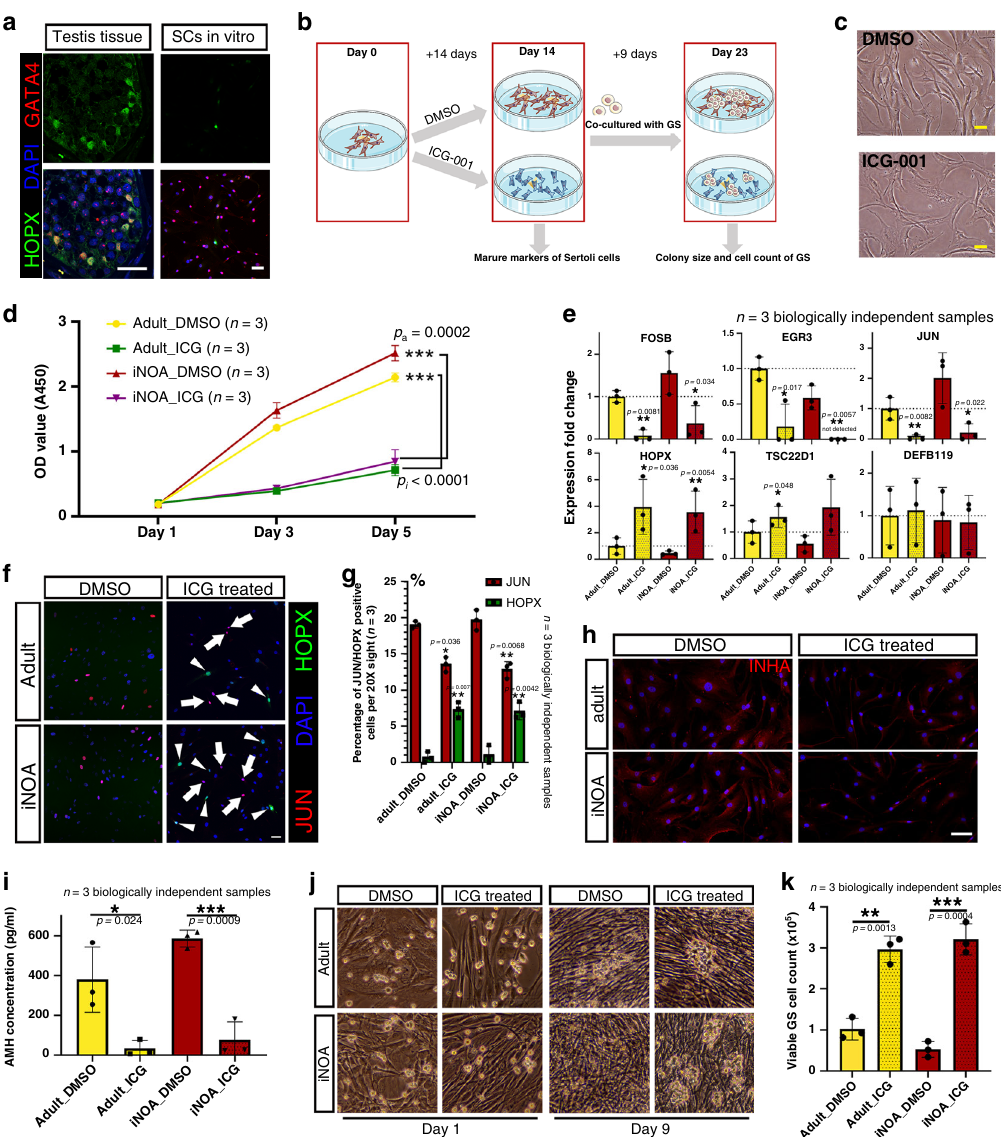
Fig. 6 Inhibition of the Wnt pathway induced the maturation of Sertoli cells in vitro. a Immuno fl uorescence co-staining of GATA4 (red) and HOPX (green) in normal and pathological testicular paraf fi n sections and cultured Sertoli cells. The scale bar represents 40 μ m. b Schematic illustration of the Wnt pathway inhibition experiment. c The morphology of cultured Sertoli cells with or without ICG treatment. The scale bar represents 20 μ m. d Sertoli cells treated with ICG proliferated faster than DMSO-treated controls in vitro, as indicated by CCK-8 assay. Data shown as mean ± SD from three biologically independent samples and two times independent experiments, statistical analysis made by two-tailed, Student ’ s t -test; the con fi dence interval is 95%. *** p < 0.001 (comparing with normal adult). e qPCR results showing the expression fold change of six stage-speci fi c markers in cultured iNOA and normal adult Sertoli cells with or without ICG treatment. The gene expression levels of normal adult Sertoli cells without ICG treatment (DMSO treated) were used as the baseline values. Data shown as mean ± SD from three biological independent samples. Statistical analysis made by two-tailed, unpaired Student ’ s t -test; the con fi dence interval is 95%. * p < 0.05, ** p < 0.01, *** p < 0.001 (comparing with normal adult). f , g Immuno fl uorescence co-staining of JUN (red) and HOPX (green) in cultured iNOA and normal adult Sertoli cells with or without ICG treatment ( f ). The scale bar represents 20 μ m. The statistics of JUN/HOPX positive cells count is shown as histogram ( g ). Data shown as mean ± SD from three 20X sights. This experiment was repeated two times independently with similar results. Statistical analysis made by two-tailed, unpaired Student ’ s t -test; the con fi dence interval is 95%. * p < 0.05, ** p < 0.01, *** p < 0.001 (comparing with DMSO treated group). h Immuno fl uorescence of INHA (red) in cultured iNOA and normal adult Sertoli cells with or without ICG treatment. The scale bar represents 20 μ m. i ELISA results showing the difference in AMH concentration in the supernatant of cultured iNOA and normal adult Sertoli cells with or without ICG treatment. Data shown as mean ± SD from three independent samples. Statistical analysis between ICG and DMSO treatment group made by two-tailed, unpaired Student ’ s t -test; the con fi dence interval is 95%. * p < 0.05; *** p < 0.001 (comparing with DMSO treatment group). j , k The morphology of cultured GS cell colonies when normal adult or iNOA Sertoli cells with or without ICG treatment are used as feeder cells ( j ). The statistics of viable GS cells count is shown as histogram ( k ). Images were taken with a ×20 magni fi cation microscope. Data shown as mean ± SD from three independent samples. Statistical analysis between ICG and DMSO treatment group made by two-tailed, unpaired Student ’ s t -test; the con fi dence interval is 95%. ** p < 0.01; *** p < 0.001 (comparing with DMSO treatment